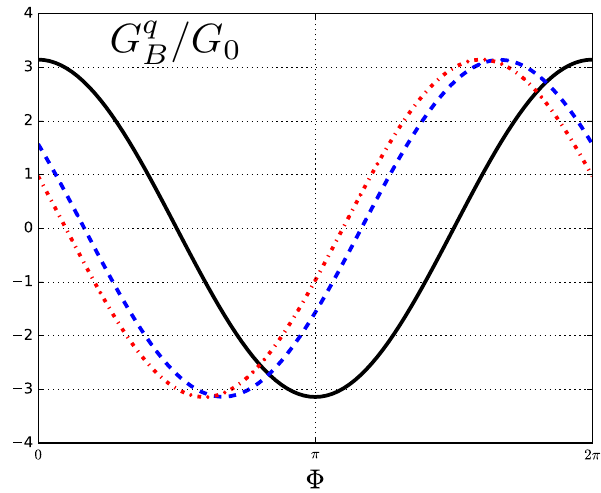
, calculated at 0